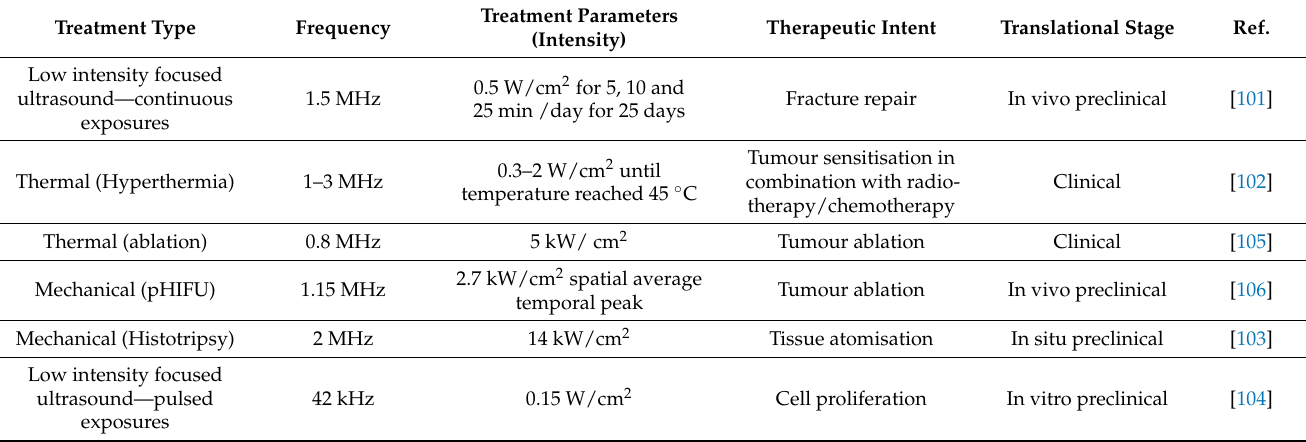
pulsing regimes, are in the order of 200 µ s/800 µ s “On time/Off time” [97–104] (Table 1). Table 1. Examples of frequencies and intensities used in focused ultrasound treatments with thera- peutic